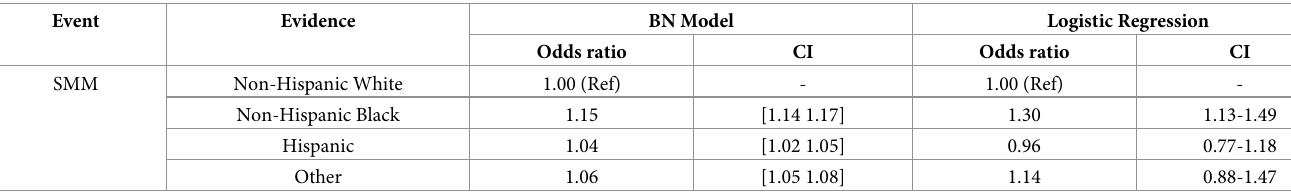
Table 4. Comparison of SMM risk using BN approximate inference and logistic